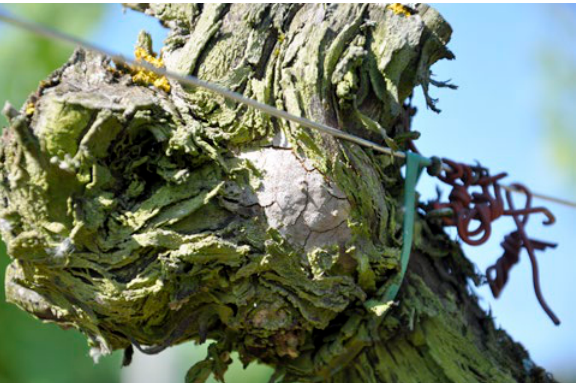
Figure 4. Typical appearance of Fomitiporia mediterranea fruitbody in the uppermost part of a Vitis vinifera trunk. Fruitbodies are perennial; cracks indicate dry weather conditions (i.e., winter in Central Europe). Photograph: M.